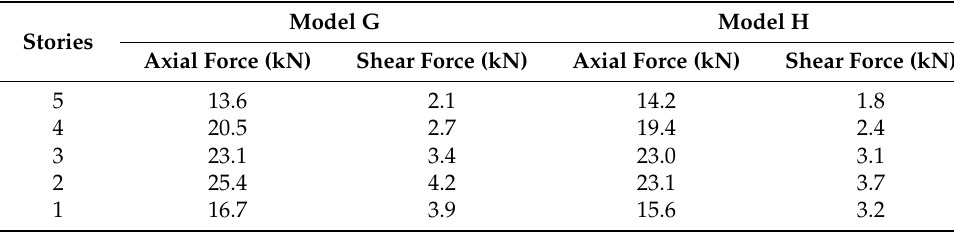
Table 18. A comparison of the internal force of the ladder